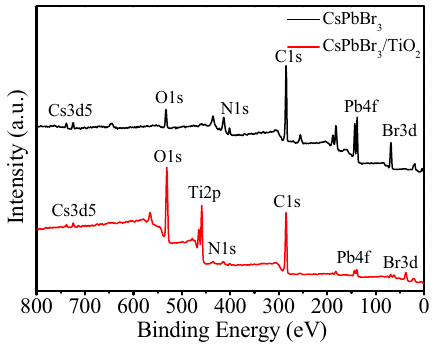
Fig. 6 XPS spectra of CsPbBr